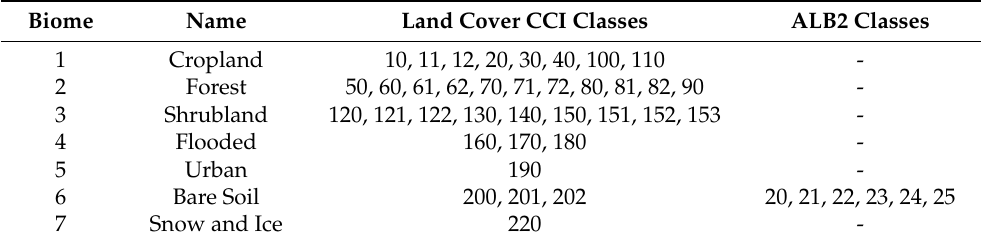
Table 2. Biome definitions for PDF LUT binning over land surfaces as described by the Land Cover CCI Classes [28] and the ATSR LST Biome Classification (ALB2) classes